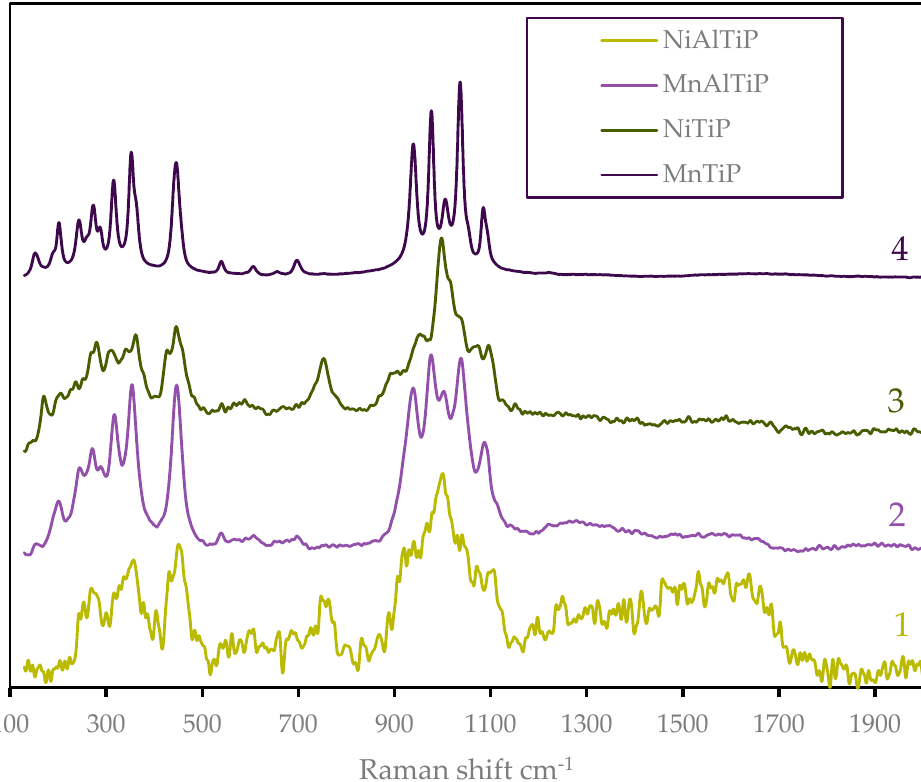
Figure 2. Raman spectra of (1) NiAlTi, (2) MnAlTi, (3) NiTi, (4) MnTi.